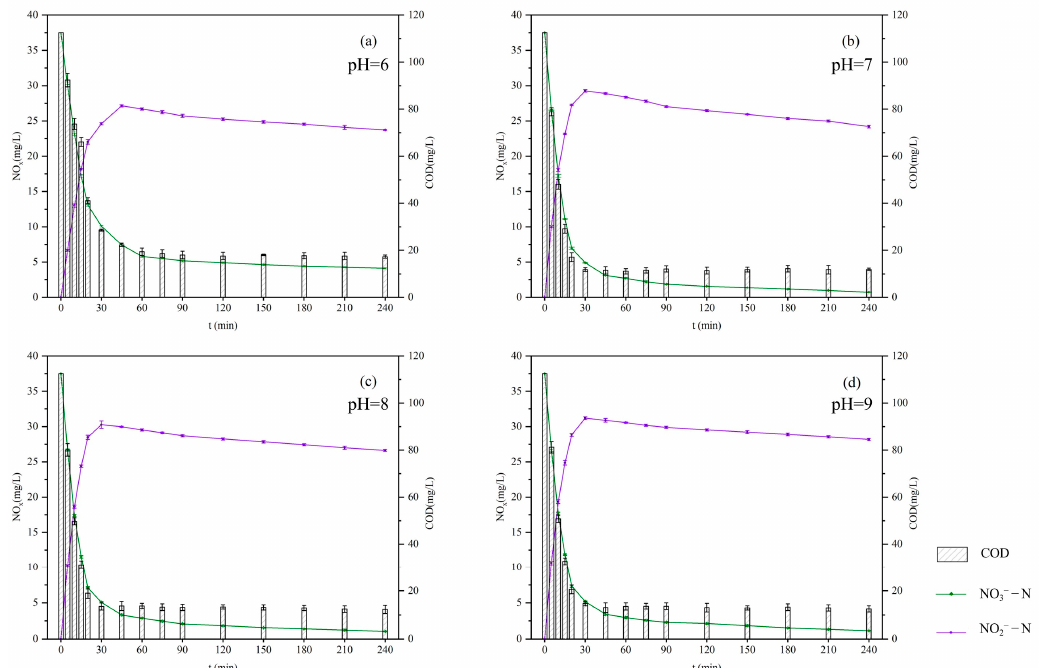
Figure 6. Changes of substrate concentration under different influent pH: ( a ) 6; ( b ) 7; ( c ) 8; ( d ) 9.